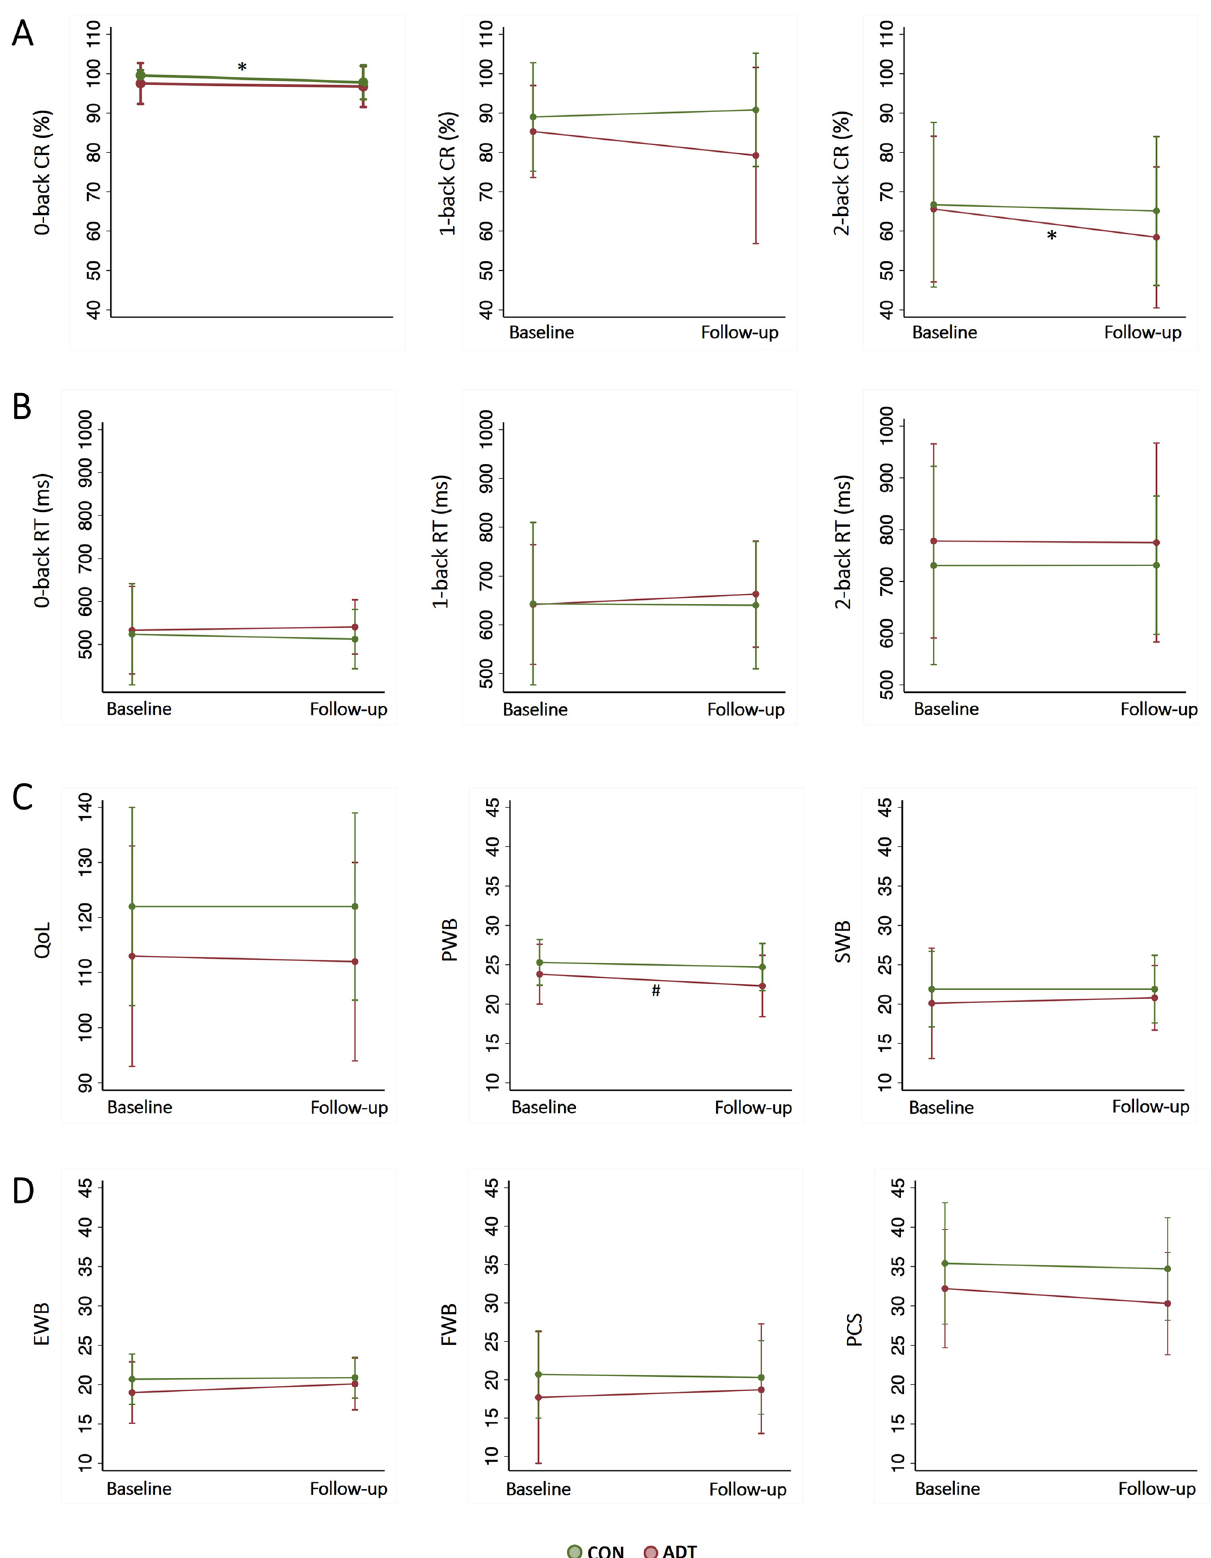
Figure 1. Distribution of ( A ) N-back correct response rates (%), ( B ) N-back response time (ms), ( C ) quality of life (QoL) score and sub-scores—physical well-being (PWB), subjective well-being (SWB), ( D ) emotional well- being (EWB), functional well-being (FWB)—and prostate cancer specific (PCS) score at baseline and follow-up in ADT (red) and CON (green). Data shown in group mean ± SD. CR correct response, RT reaction time. *p < 0.05, # p = 0.078 in paired